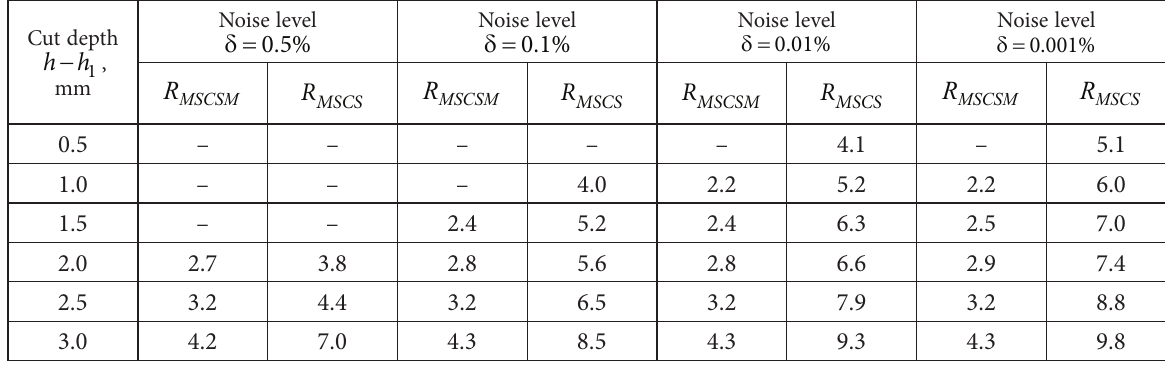
table 2. Damage detection